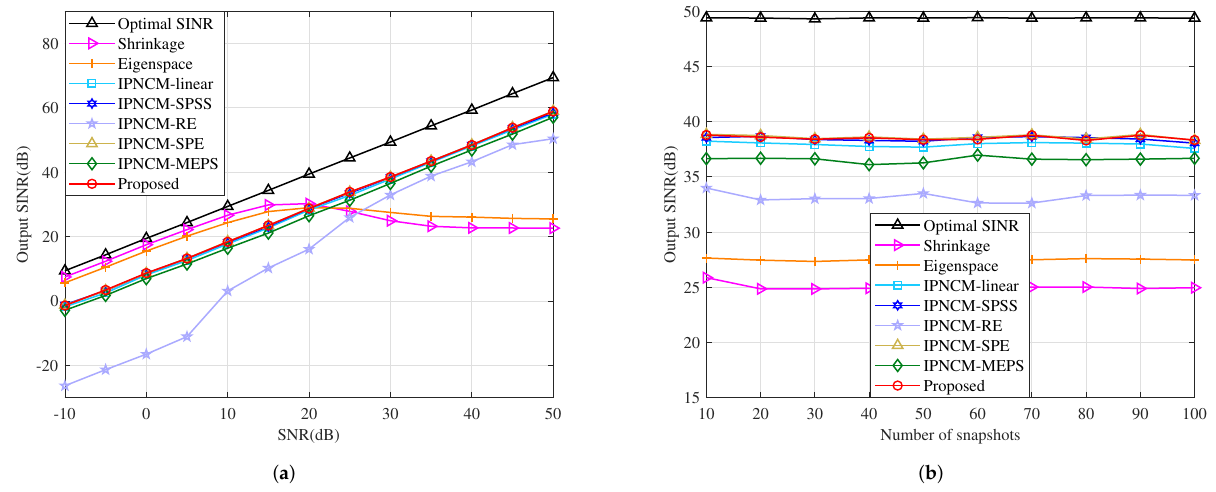
Figure 12. Output SINR in the case of gain and phase error versus ( a ) input SNR, JNR = 30 dB, K = 50. ( b ) the number of snapshots, SNR = 30 dB, JNR = 30